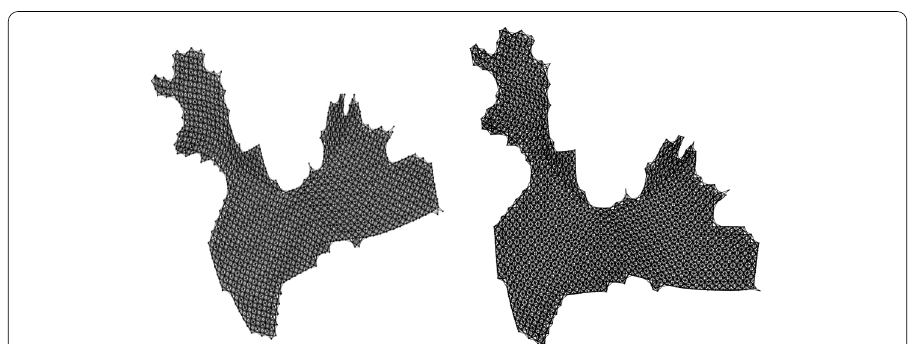
Figure 4 plat1919, left: result from [26], right: our result